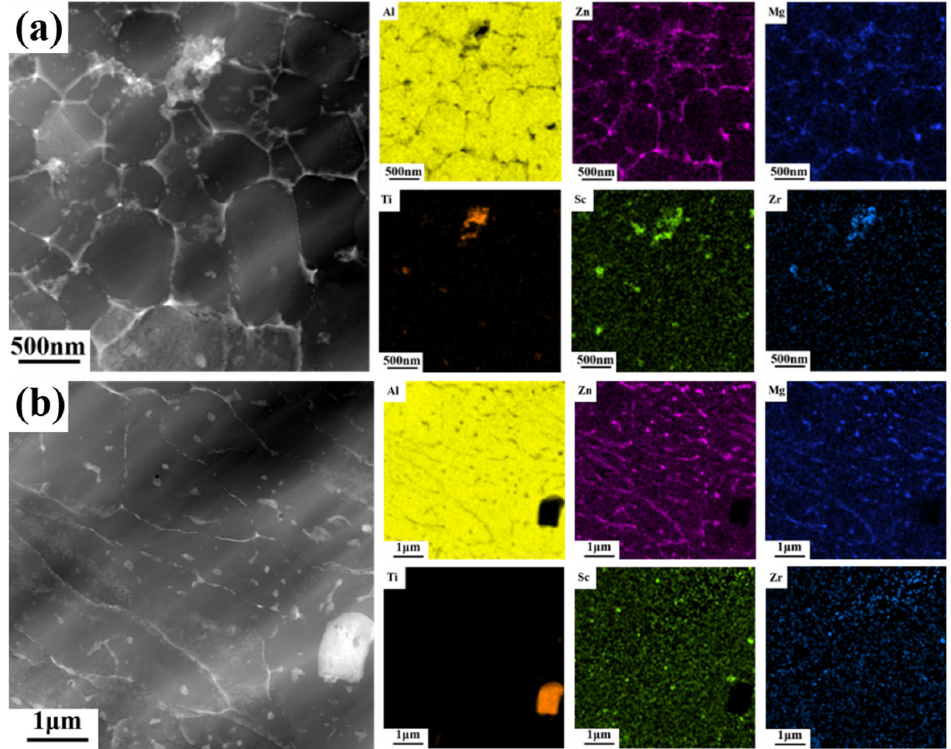
Figure 8. STEM HAADF images of SLM-fabricated TiB 2 /AlZnMgCu(Sc,Zr) composite as-printed samples and corresponding EDX mapping of the solute elements (Al, Zn, Mg, Ti, Sc, Zr) ( a ) in the fine grain region and ( b ) in the columnar grain region.